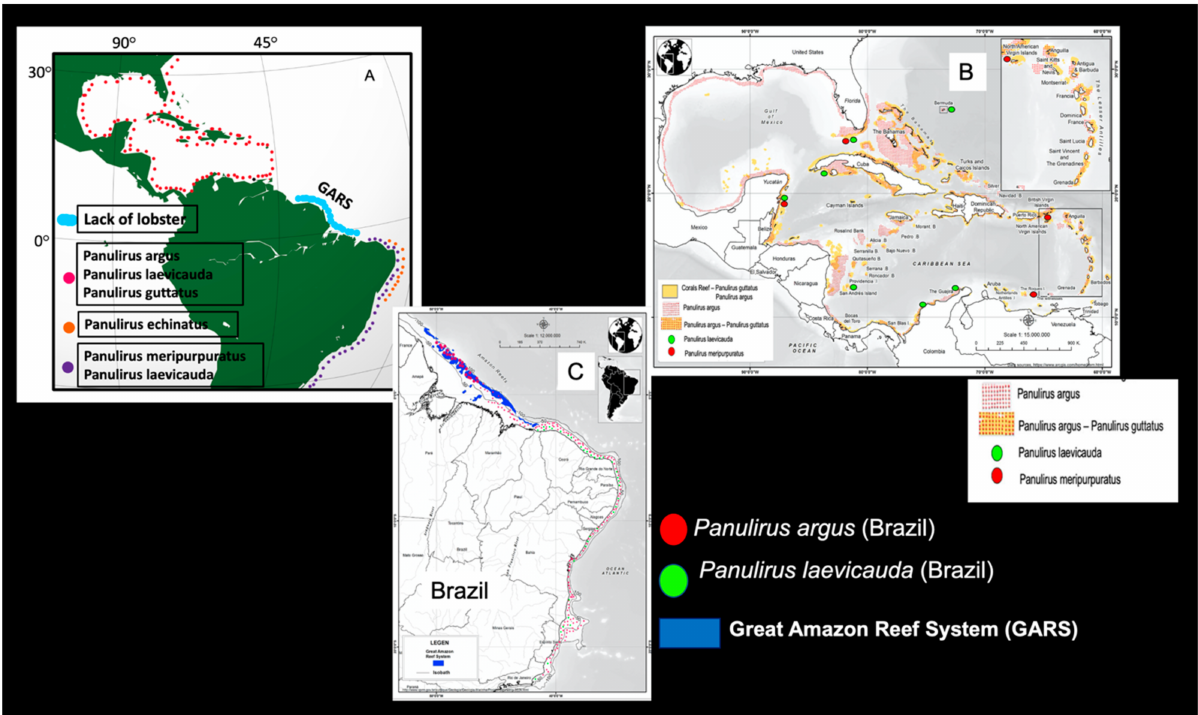
Figure 1. Spatial distribution of lobsters of genus Panulirus (White, 1847). ( A ) Map adapted from Giraldes & Smyth [27]. ( B ) Map adapted from Cruz et al. [6]. ( C ) Map adapted from Cruz et al.